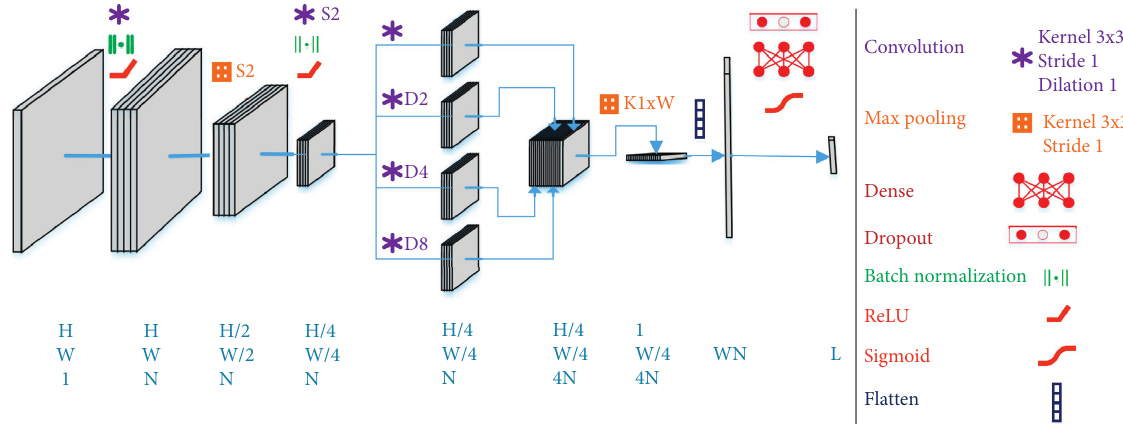
Figure 2: The proposed network. N � 64, H � 64, W � 160, and L �